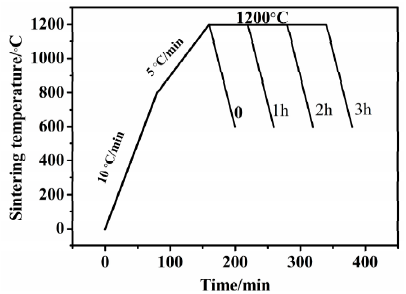
Figure 1. Heating profile of the Fe-28Mn-3Si powder mixture sintered at 1200 °C for different isothermal holding times.